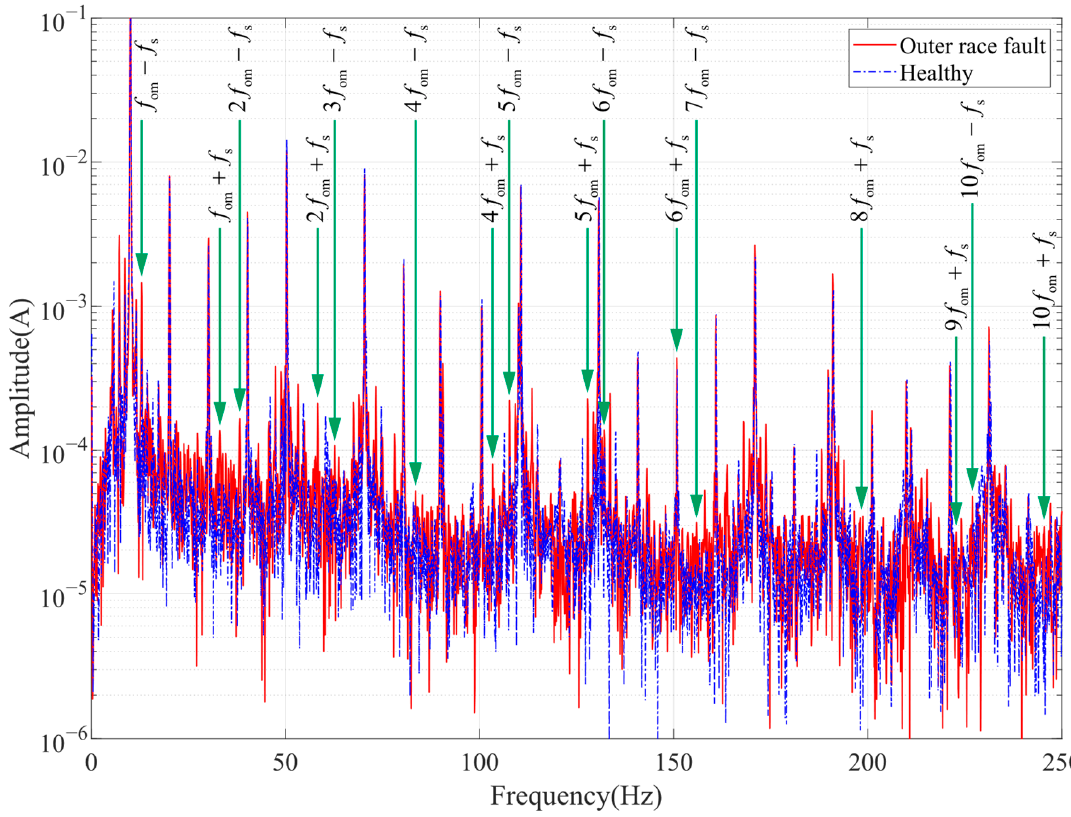
Figure 22. Comparison of stator current experimental signal spectrum under outer race fault (10 Hz).